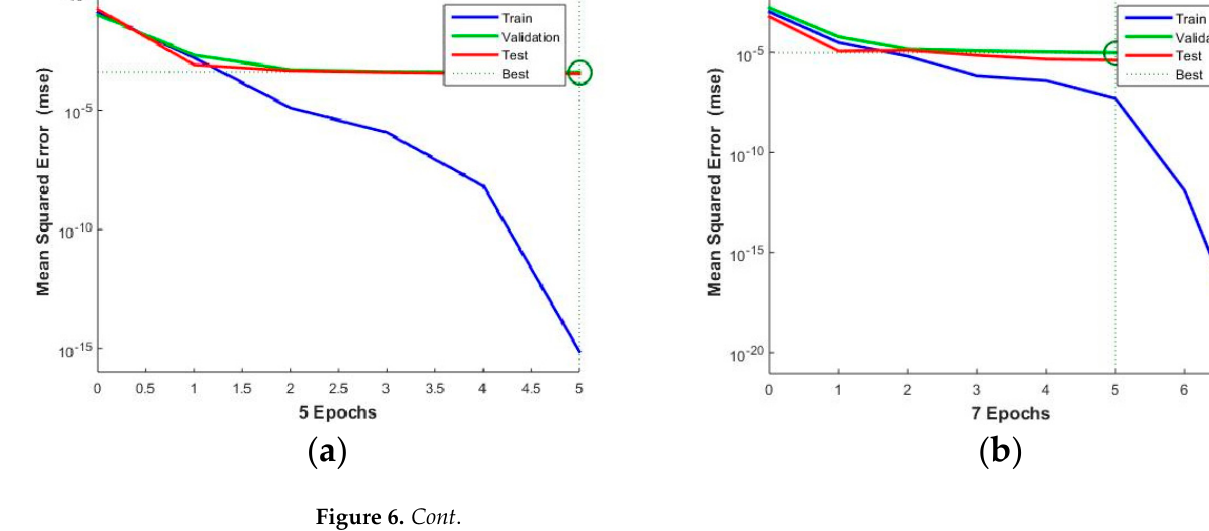
( d ) Figure 6. Network training: ( a ) NN1, ( b ) NN2, and ( c ) NN3 for determining the parameters of thick- ness, expansion, and diffusivity of the TiO 2 thin − film, respectively, and ( d ) NN4 for determining all three data, simultaneously. 6.1. Networks Testing with In-Step, Out-Step of Photoacoustic Signal As we said in the previous paragraph, four signals that did not participate in the training were separated from each training base of the NN1-3 networks. A similar thing was carried out with the training base for the NN4 network, from which 12 signals were separated and did not participate in the training. All four networks were tested with these “in-step” signals and the results of such tests are shown in Tables 2 and 3. Relative error predictions (%) presented in these tables show that the most accurate networks are NN2 for the prediction of α T 1 and NN4 for the prediction of D T 1 . Table 2. Relative (%) error prediction of TiO 2 thin-film parameters on 4 test photoacoustic signals that are in step by NN1, NN2 and NN3 networks. Type of Network